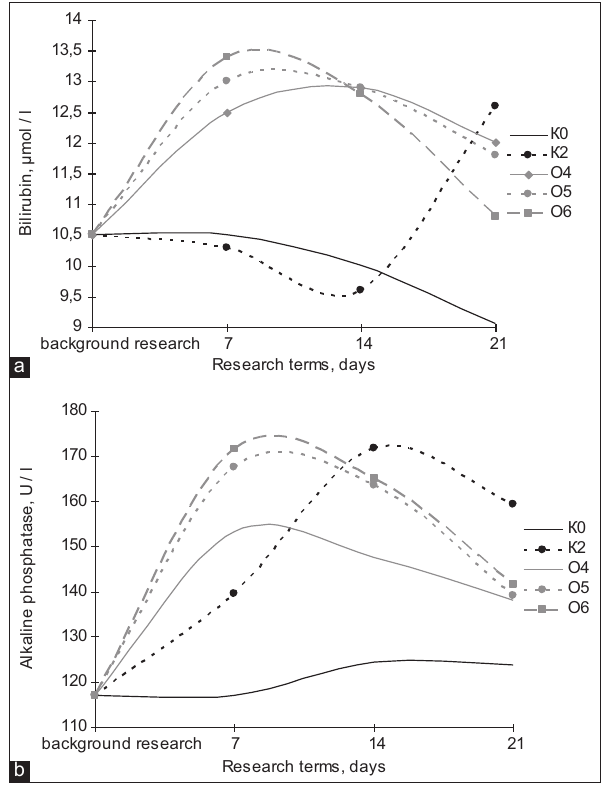
Figure-4: Dynamics of changes in the concentration of total (a) bilirubin and (b) alkaline phosphatase in laboratory animals: К – background, К – control of the metal (Cu), 0 2 О